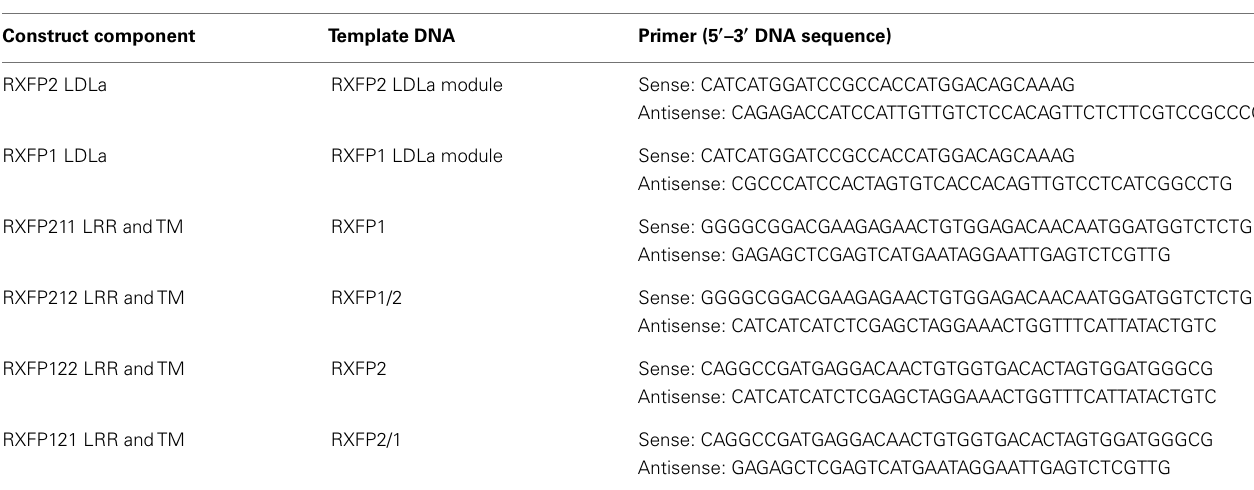
Table 1 | Primers used in overlap